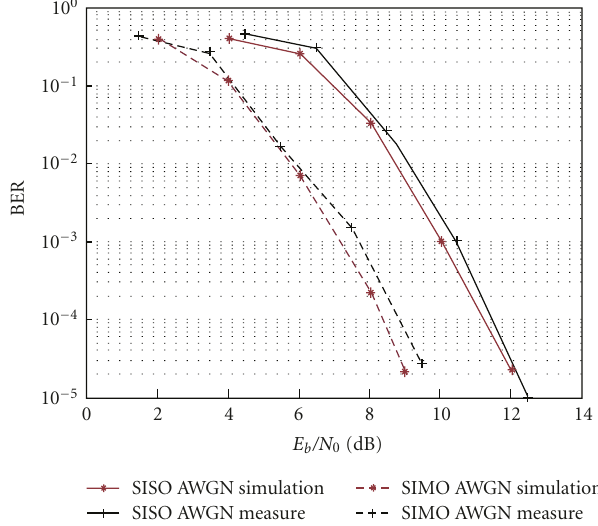
Figure 12: BER versus E b / N o for an 802.11g transmission with one or two received antennas in an AWGN channel.